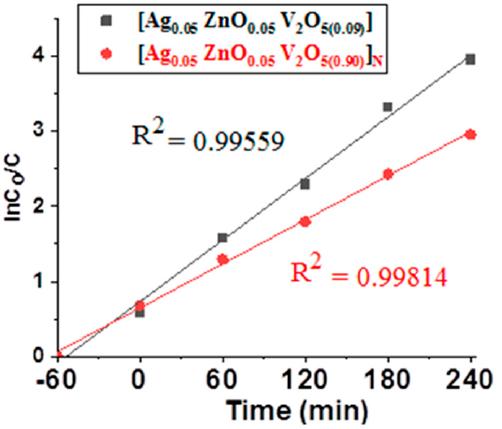
Figure 11. Kinetic expression for the employed photocatalysts at the catalyst dose of 1 g L − 1 .